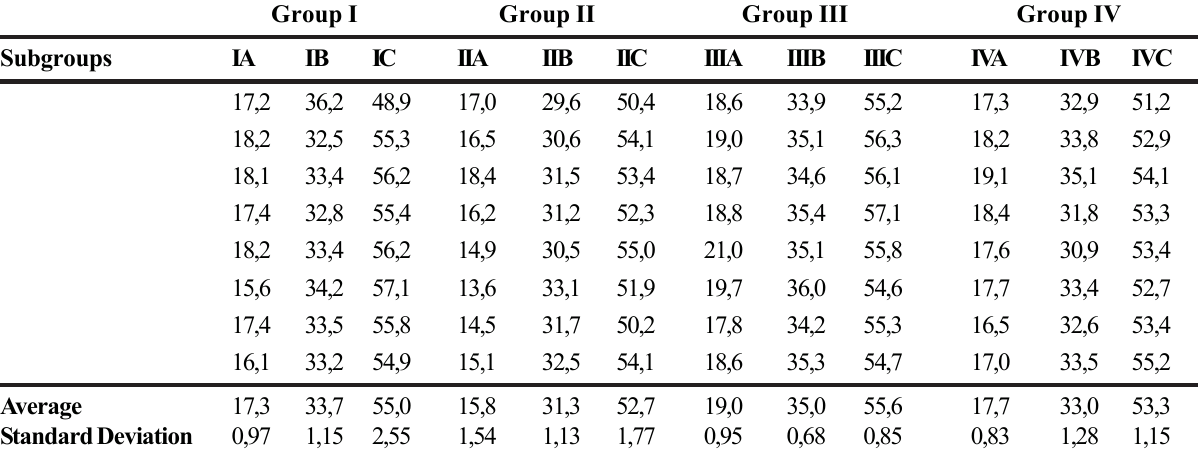
TABLE 1 - Results of the quantitative analysis of the percentile of area of the bony defect filled by bony trabeculae in all groups and respective subgroups A, B and